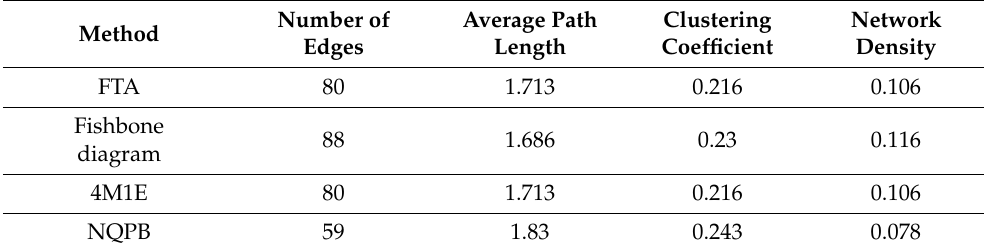
Table 6. Simulation